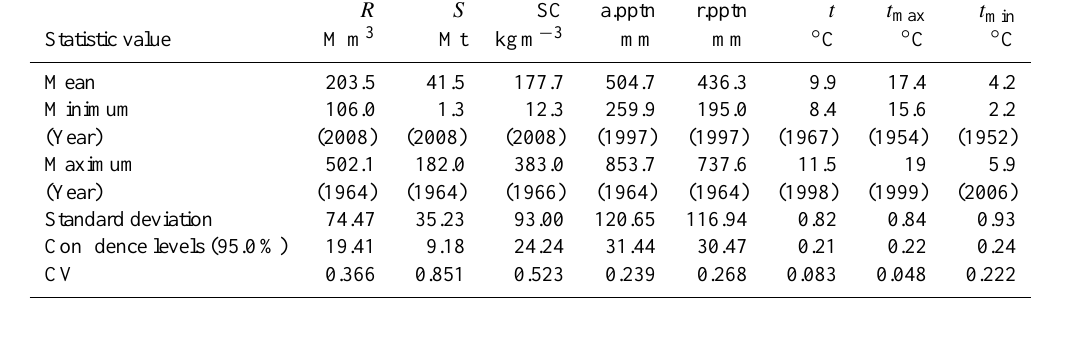
Y a.pptn = -0.869x + 2225.6 R² = 0.0153, P>0.1 Y t = 0.038x -65.743 R² = 0.6393, P<0.001